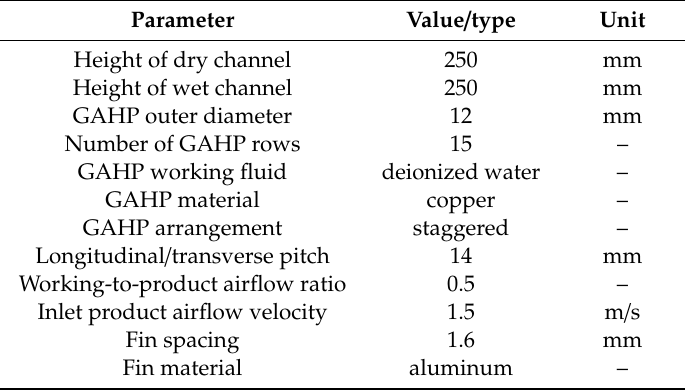
Table 6. Input operating conditions for the simulation.